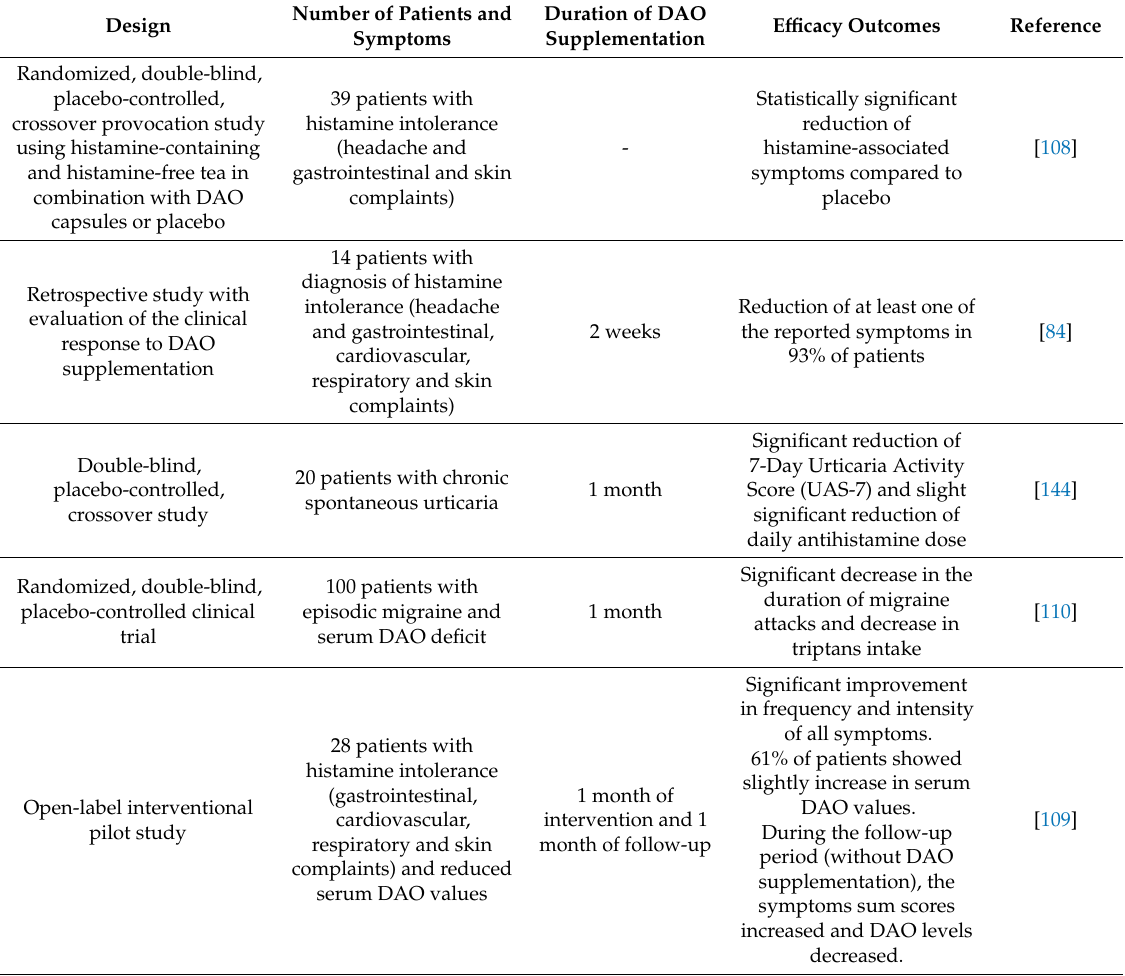
Table 5. Studies on the e ffi cacy of DAO enzyme supplementation for the treatment of symptoms of histamine